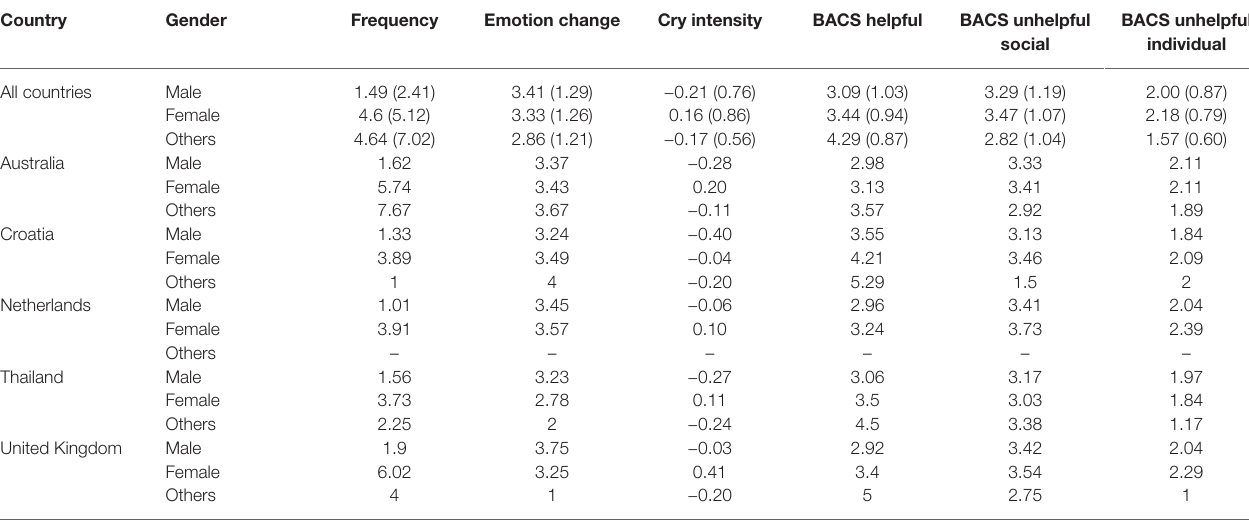
BACS unhelpful social individual